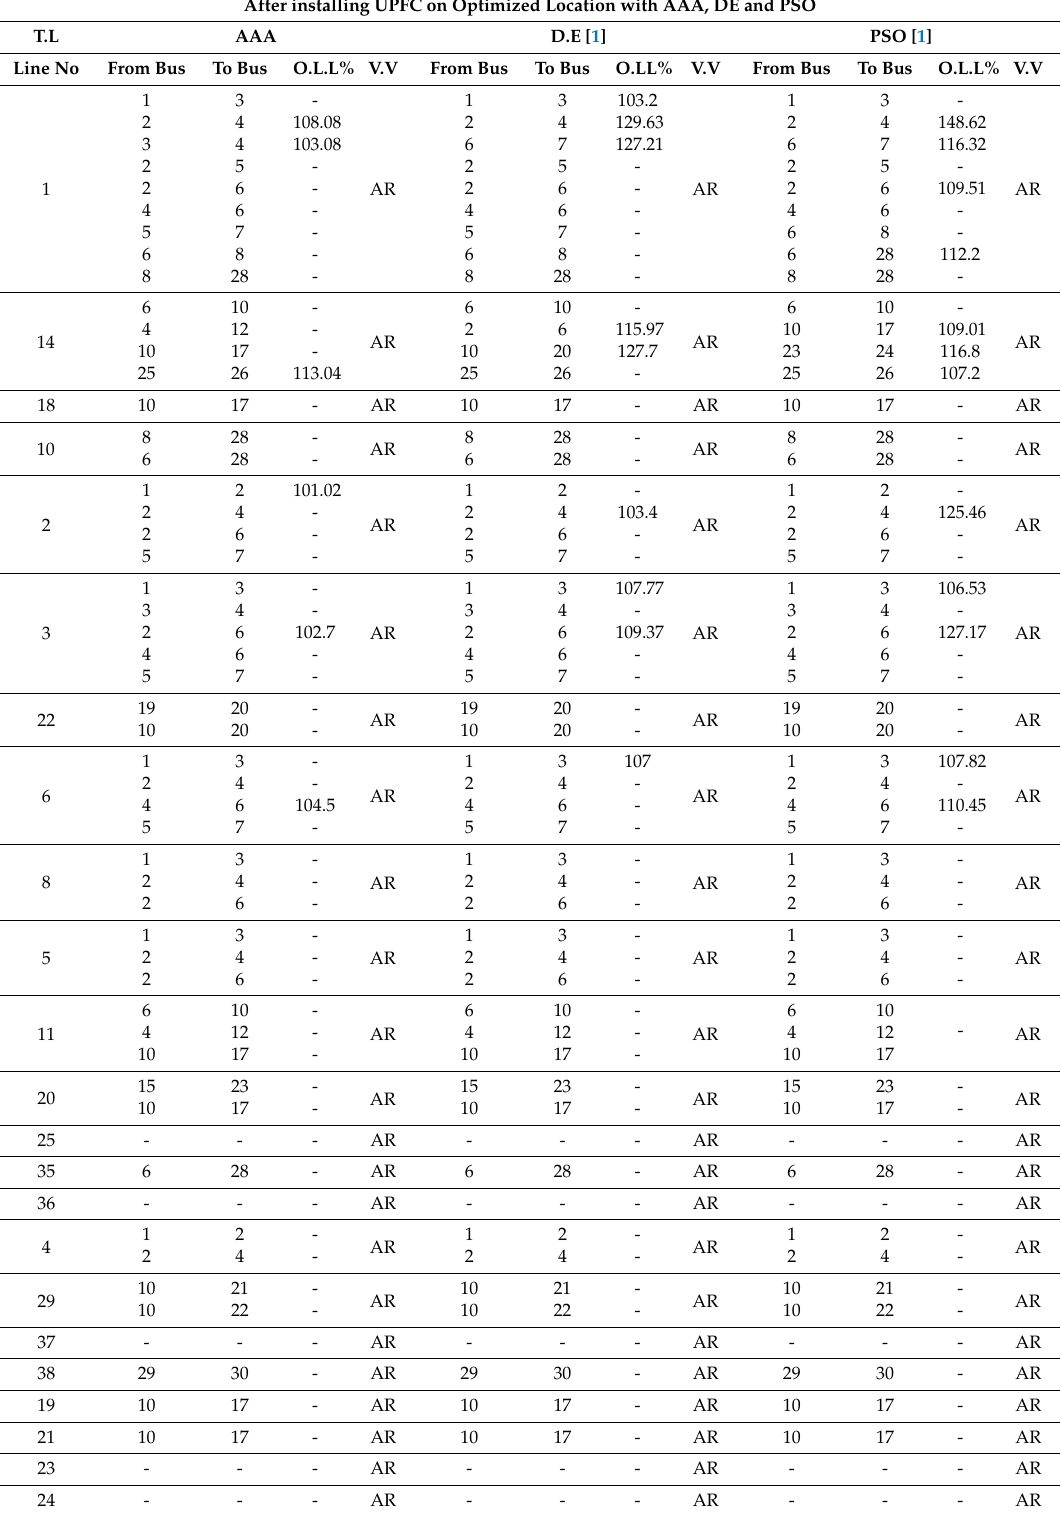
Table 9. Overloading of lines and voltage violations using UPFC at optimized location by AAA, D.E and PSO. After installing UPFC on Optimized Location with AAA, DE and PSO